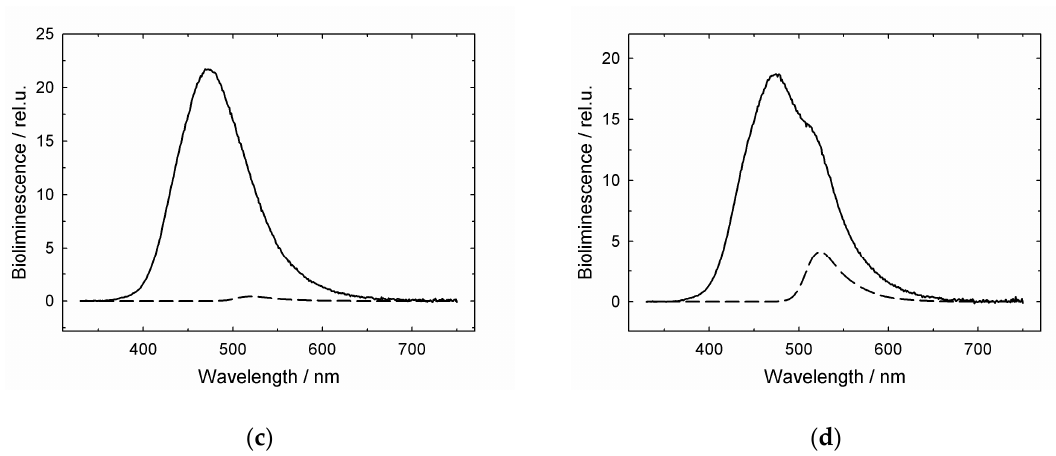
Figure 3. Bioluminescence spectra of streptavidin-aequorin fusion (SAVAq) in the presence of biotin- and fluorescein-labeled α -lactalbumin (BFL), GroEL, ATP + GroES, and free biotin added in the